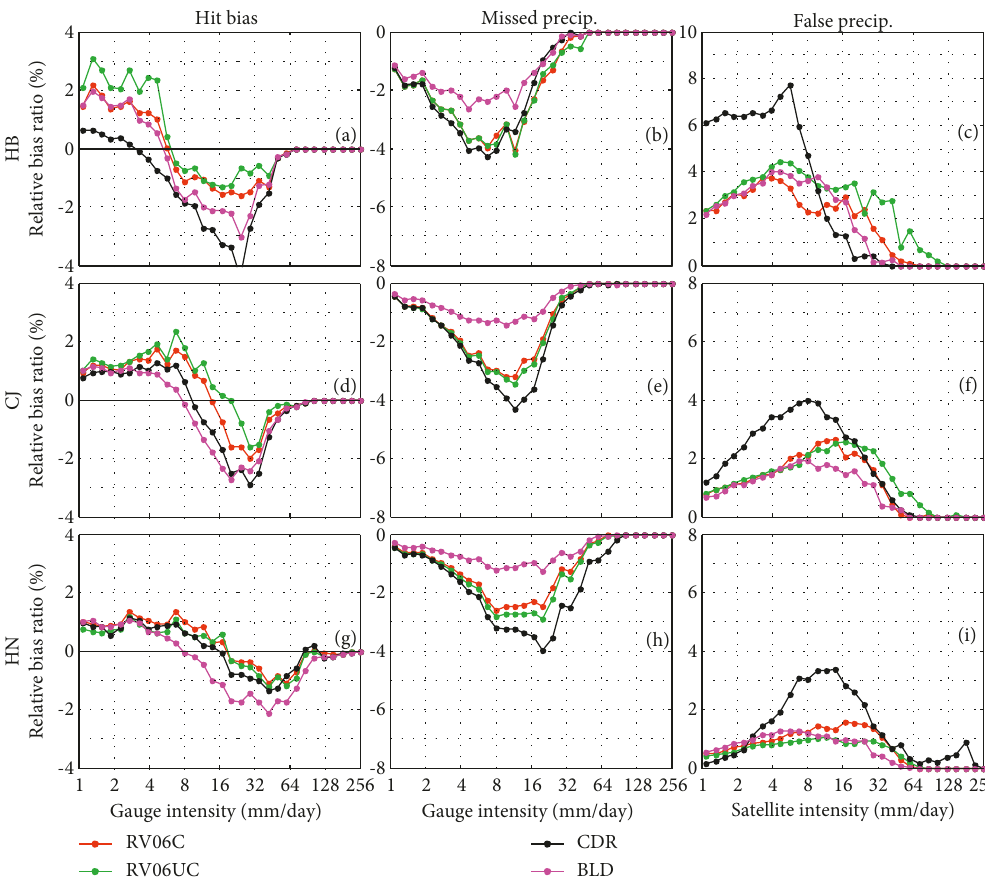
Figure 23: Same as Figure 20, but for winter